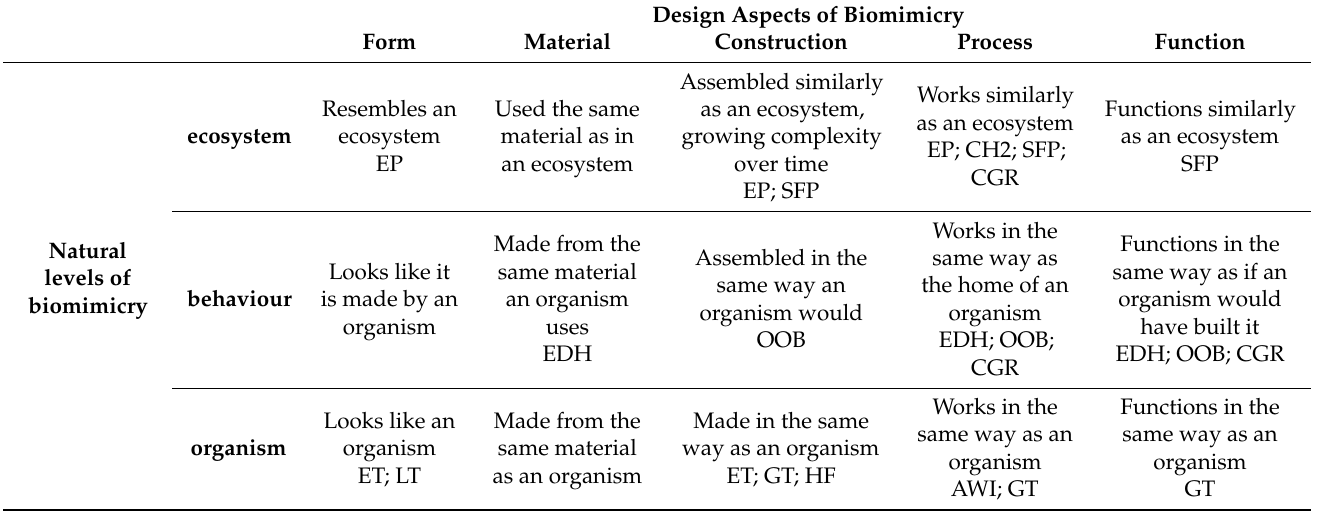
Table 4. Case studies from Section 3 classified according to the levels of biomimicry. (Left: Natural levels of biomimicry in terms of ecosystem, behaviour, or organism; top: Design aspects mimicking form, material, construction, process, or function. List of acronyms: EDH (Eastgate